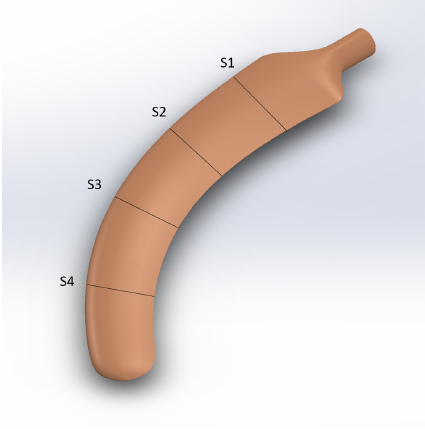
Figure 1. Three-dimensional geometry of the tip indicating the measurement sections.